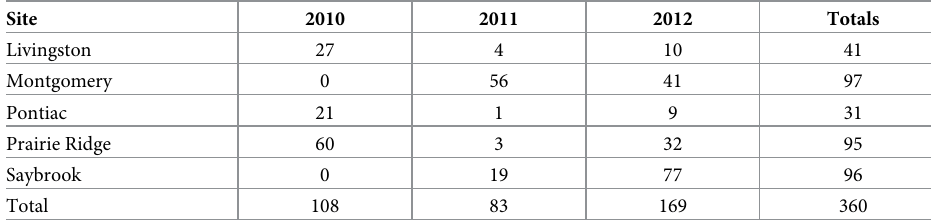
Table 1. Vole samples collected during three field seasons (2010–2012) across five SAFE sites in Illinois. Samples were harvested non-invasively from two species, M . ochrogaster and M . pennsylvanicus , but only totals are listed. Geo- graphic location of sites in Fig